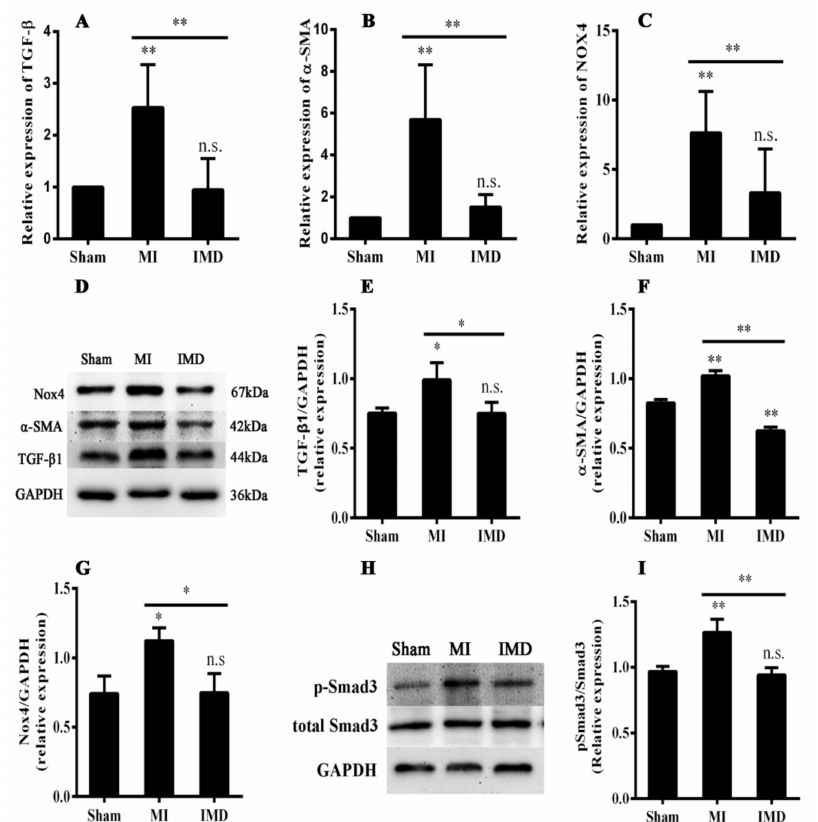
Figure 5. mRNA and protein expression of TGF- β 1, α -SMA, Nox4, and Smad3 in the left atria of rats. ( A ) mRNA expression of TGF- β 1 in rat’s left atrium. IMD1-53 reduced TGF- β 1 after MI. ( B ) mRNA expression of α -SMA in rat’s left atrium. IMD1-53 reduced α -SMA after MI. ( C ) mRNA expression of Nox4 in rat’s left atrium. IMD1-53 reduced Nox4 after MI. ( D – G ) Western blot analysis for the protein expression of TGF- β 1, α -SMA, and Nox4. IMD1-53 decreased each of these indices. ( H , I ) Representative Smad3 protein expression and phosphorylation level of Smad3 measured by Western blot in left atrium. IMD1-53 reduced the phosphorylation of Smad3 after MI. Data in the bar graphs are means ± SD, n = 10. * p < 0.05, ** p < 0.01. n.s., no